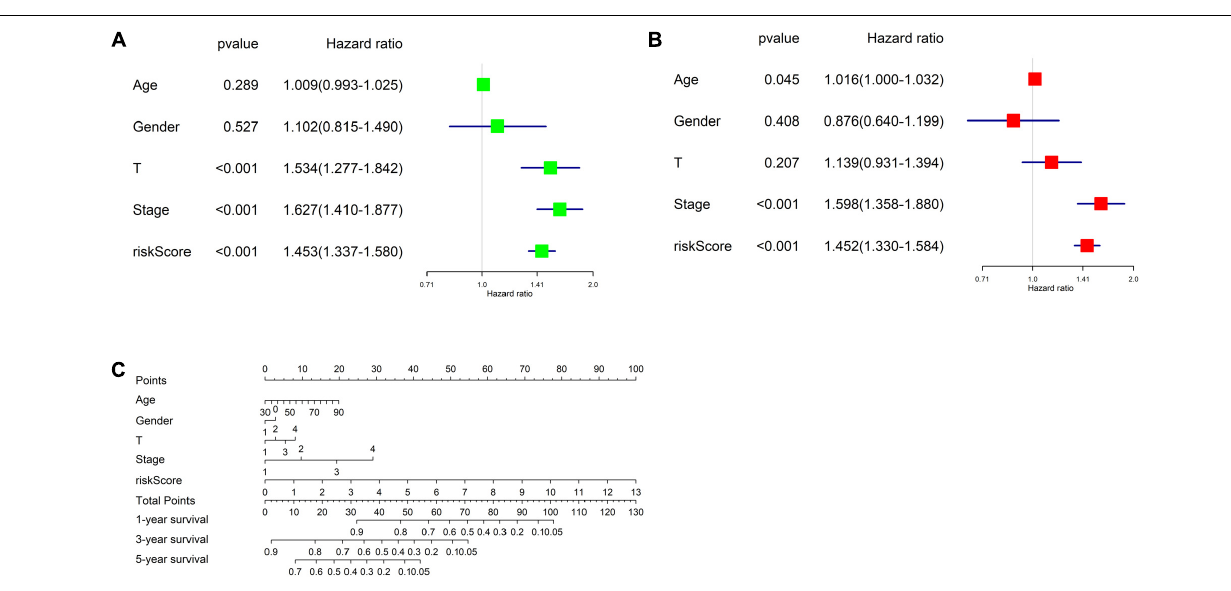
FIGURE 7 | Independent analysis of risk model and construction of nomogram. (A) Univariate Cox regression analysis in TCGA-LUAD cohort; (B) multivariate Cox regression analysis in TCGA-LUAD cohort; (C) the nomogram for predicting